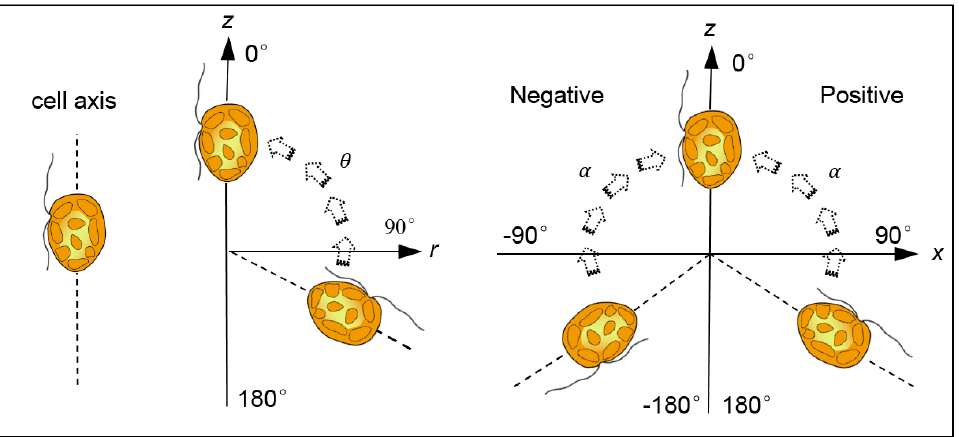
Figure 4. Definition of swimming direction. Table 1. The number of tracks at different time for three